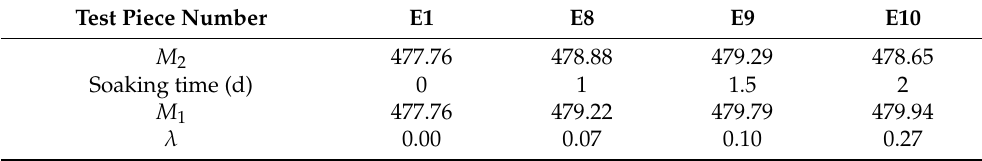
Table 2. The dried mass, soaking duration, soaking mass, and moisture content of each sample.